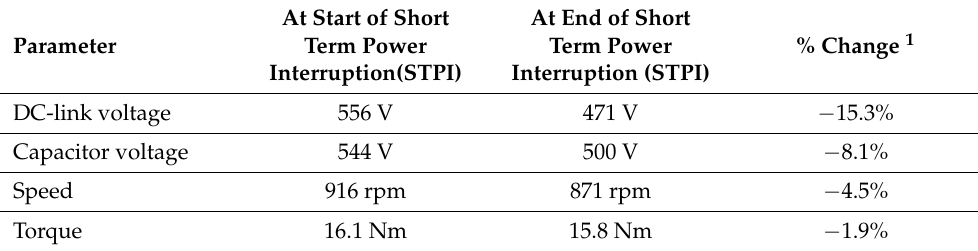
Table 2. Key simulation